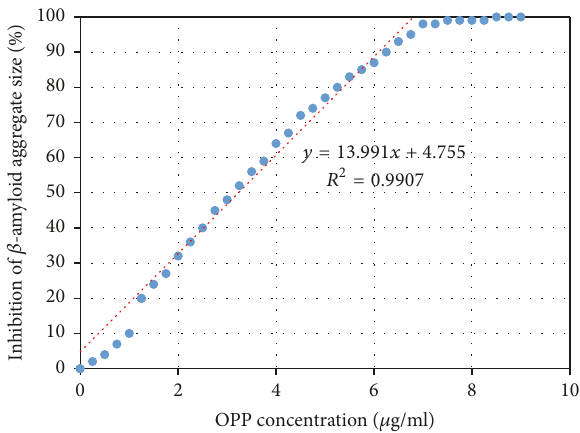
Figure 1: Spectral compensated curve for Congo Red dye binding. Dose-dependent inhibition of A 𝛽 42 aggregation by OPP. Equation (1) was used to quantify the aggregates from the spectral shift between wavelengths 403 nm and 541nm. IC50 = 3.24 𝜇 g/ml.